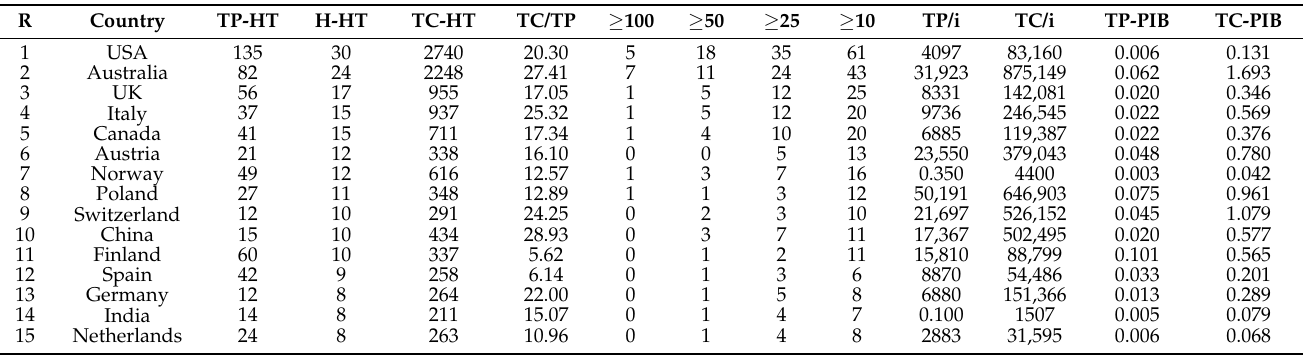
Table 7. The most influential countries in hiking and